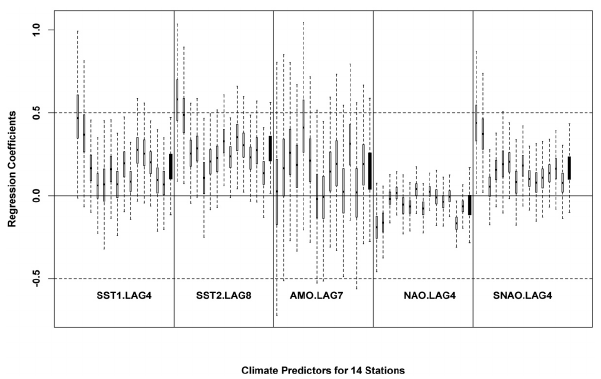
Fig. 4. Box plots of the regression coefficients β ij (open box) and the µ β j mean of the regression coefficients (filled box) for the five predictors. The first two box plots for each predictor correspond to the streamflow stations and the next 12 to the rainfall stations.